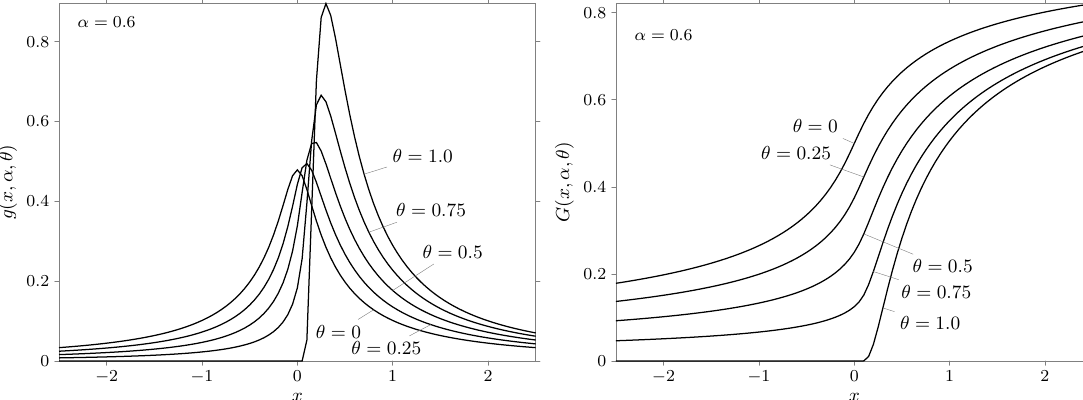
Figure 10. The probability density function g ( x , α , θ ) ( on the left ) and cumulative distribution function G ( x , α , θ ) ( on the right ) of a standard strictly stable law with α = 0.6 and specified values θ . α = 0 . 9